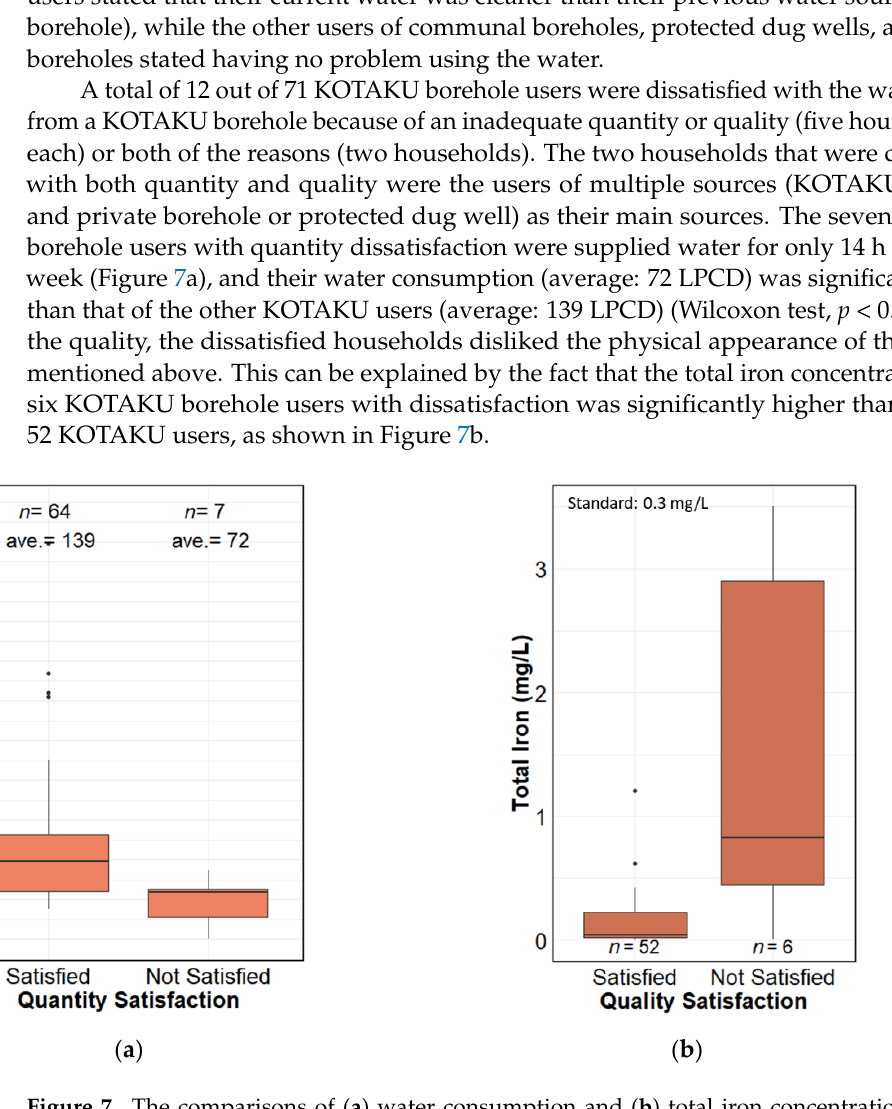
Figure 7. The comparisons of ( a ) water consumption and ( b ) total iron concentration based on KOTAKU borehole user satisfaction with water quantity and quality.